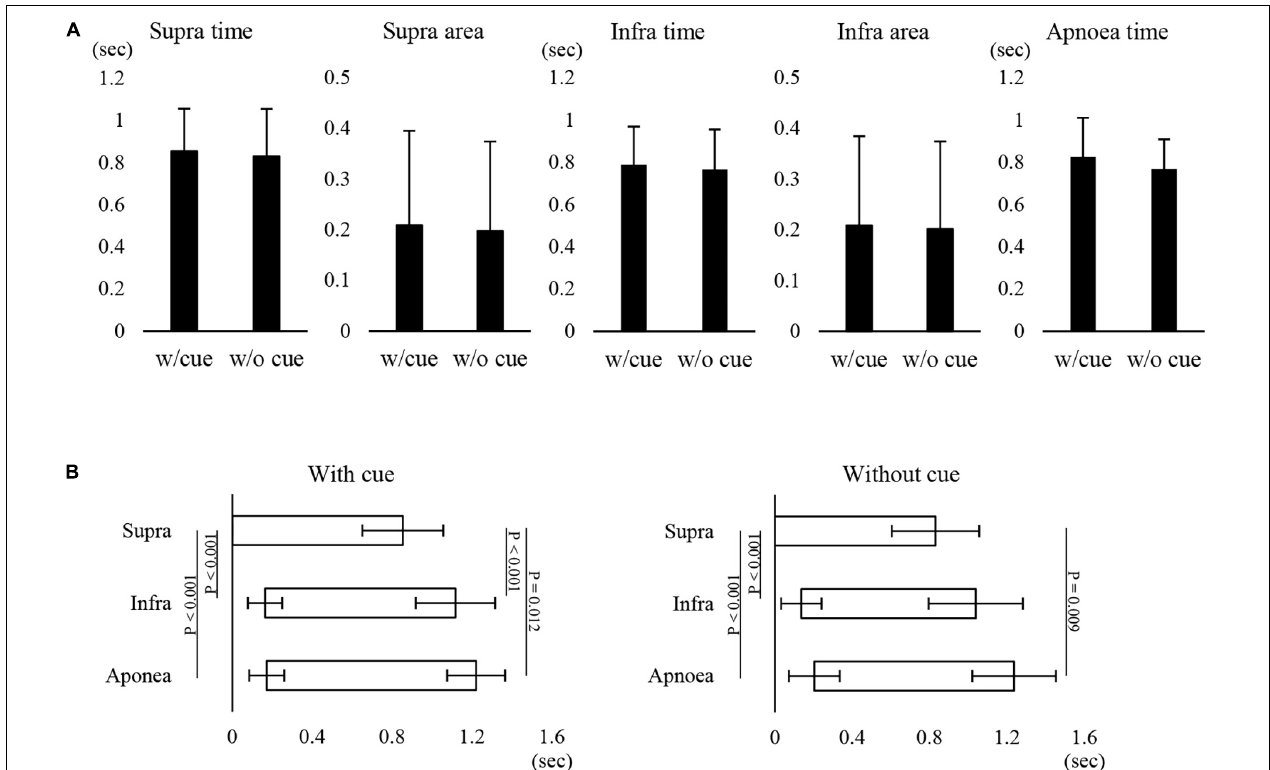
FIGURE 2 | Effect of cueing on 3-ml water swallowing behaviors in all cases. (A) There were no differences in the suprahyoid (Supra) electromyography (EMG) burst duration (Supra time) or area (Supra area), infrahyoid (Infra) EMG burst duration (Infra time) or area (Infra area), or swallowing apnoea time between with (w/cue) and without cue (w/o cue) (paired t -test). (B) In with (left) and without cue (right) conditions, the onset and offset of Supra EMG burst were followed by those of Infra EMG burst and swallowing apnoea (Apnoea) (one-way repeated measures ANOVA followed by Tukey test for onset with cue, P < 0.001, df = 2, F = 51.866; one-way repeated measures ANOVA on ranks followed by Tukey test for offset with cue, P < 0.001; one-way repeated measures ANOVA on ranks followed by Tukey test for onset without cue, P < 0.001; one-way repeated measures ANOVA on ranks followed by Tukey test, P < 0.001). The results of post hoc test are shown in the